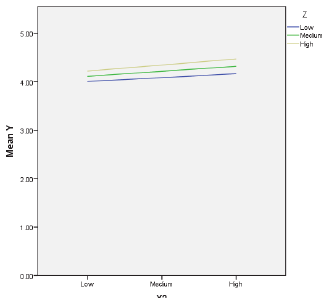
Fig. 3. Regression with Conditional Value Work Passion Behavior (Z) Over Workplace Spirituality